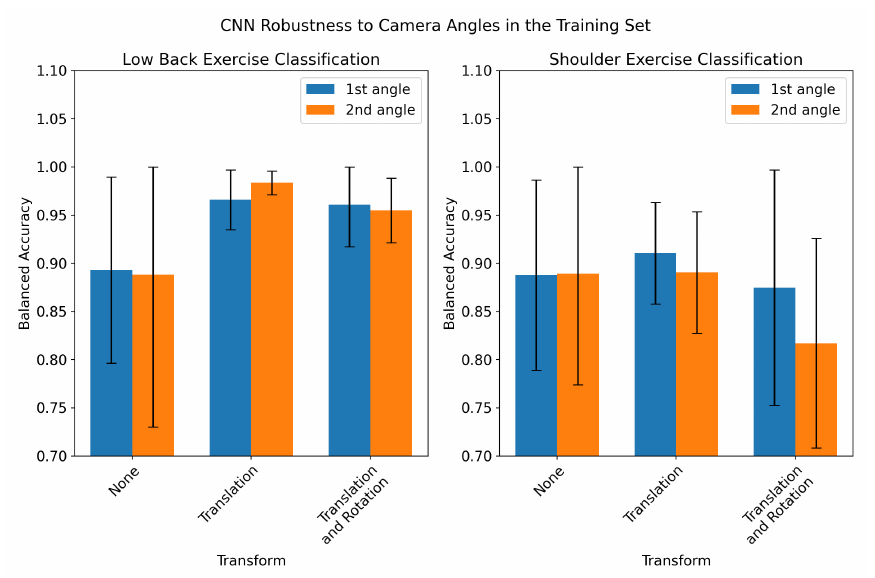
Figure 5. CNN robustness to camera angles in the training set. The CNN was trained on records from both camera angles for each exercise and tested on both camera angles in a 5-fold cross validation approach, splitting folds by subject. This was repeated for both low back ( left ) and shoulder ( right ) classification tasks, using each coordinate transform.